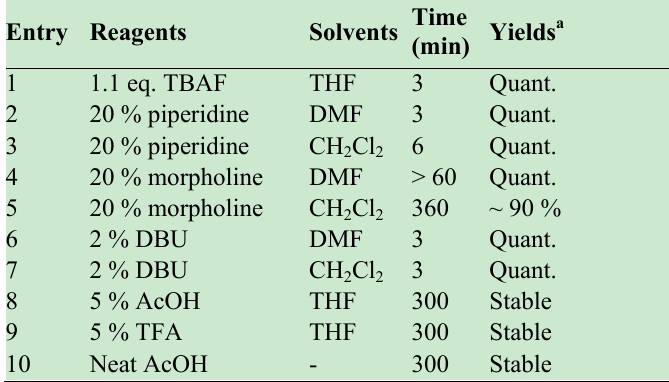
Table 1. Investigation of stability and suitable cleavage conditions of the Fsec group. Entry Reagents Solvents